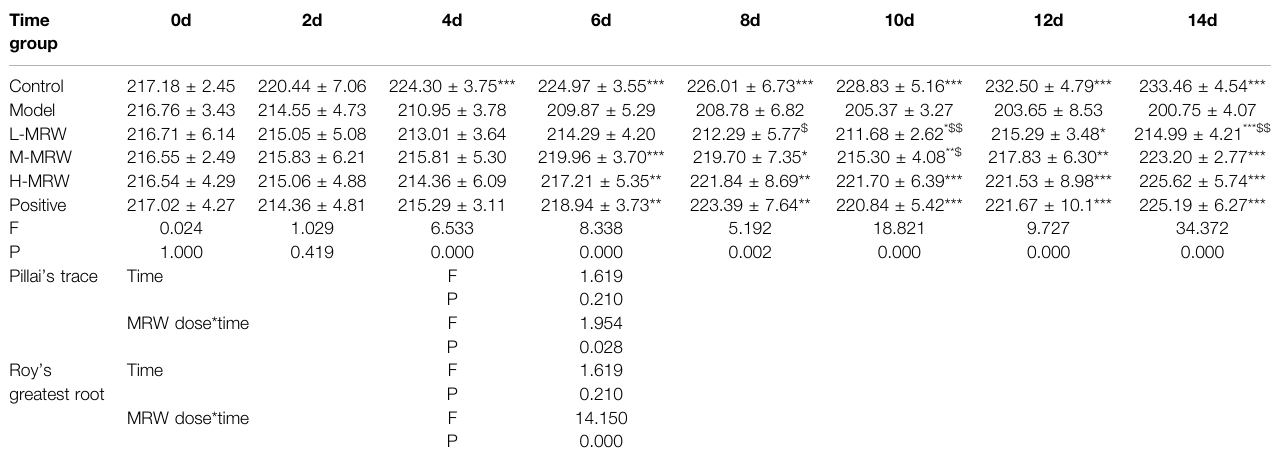
TABLE 2 | Changes in the body weight of the